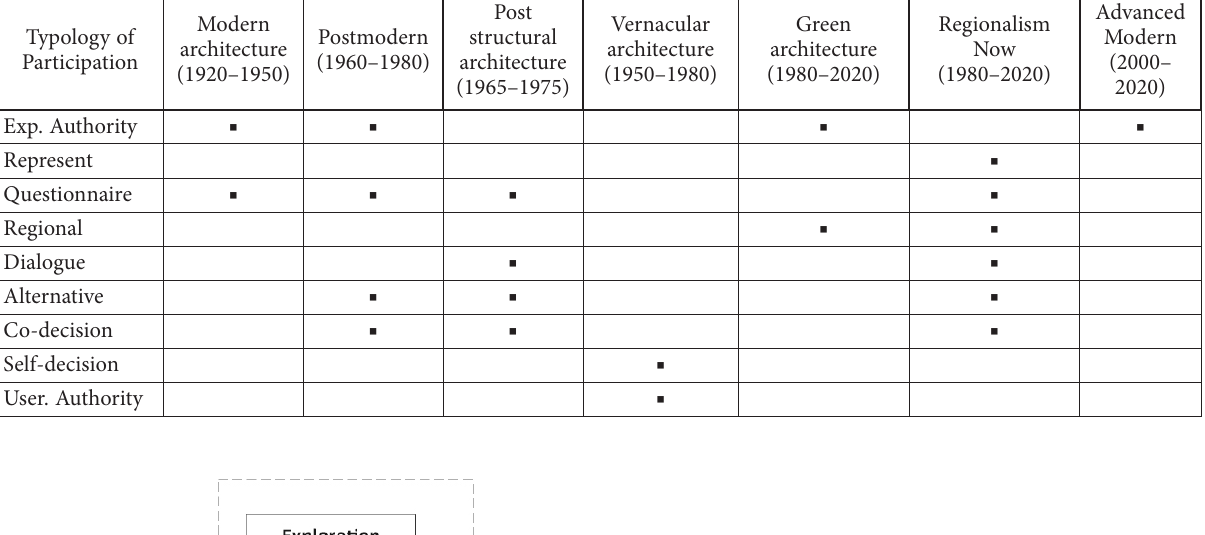
Typology of Participation